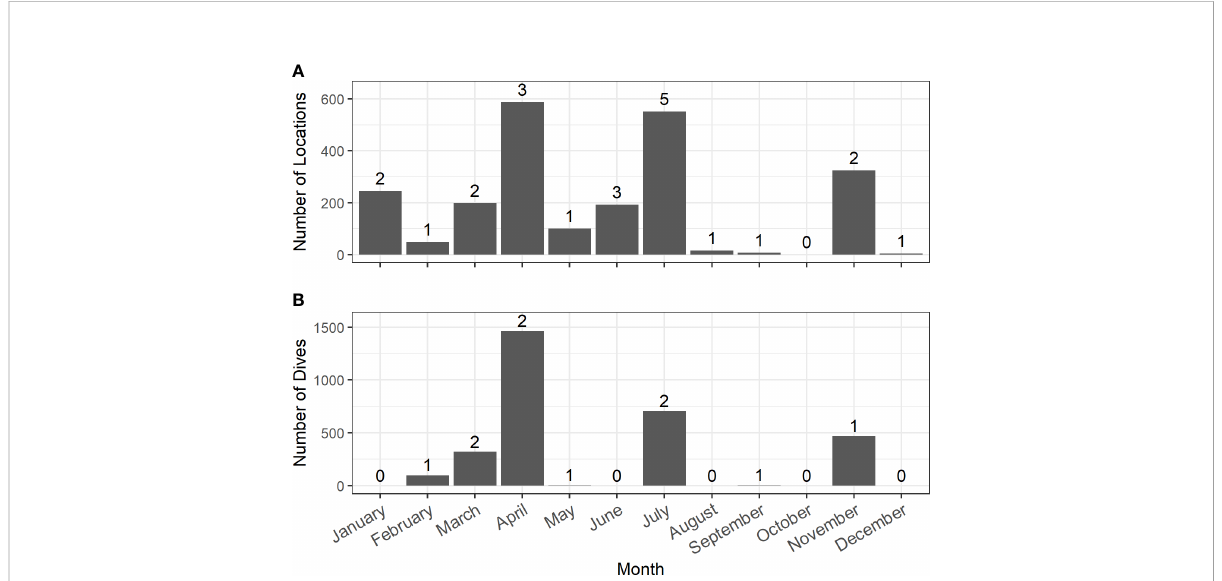
FIGURE 2 Distribution of fi ltered locations ( A , from 16 tags) and dives ( B , from 8 tags) across months from satellite tags deployed on Risso ’ s dolphins in the Southern California Bight between 2009 – 2019. The number of tags that contribute to monthly data are denoted above each